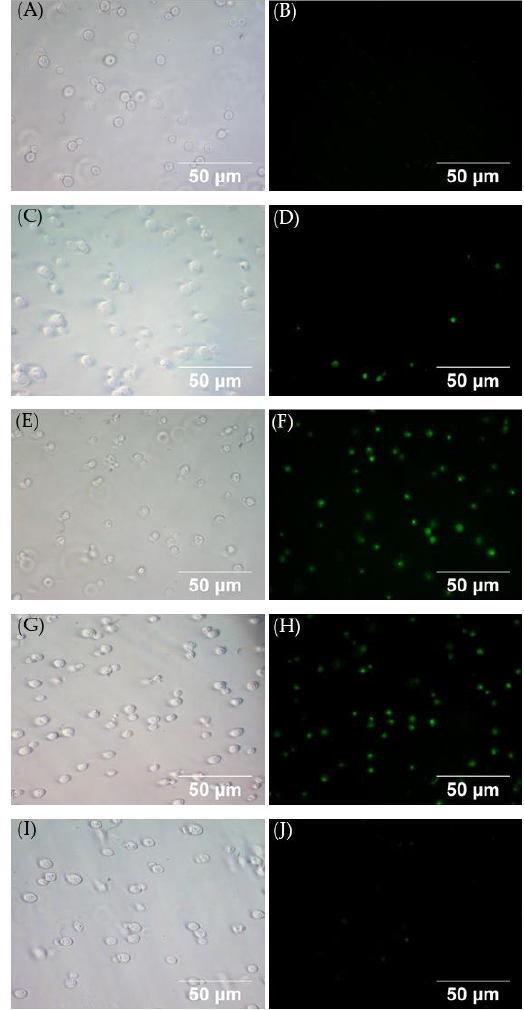
Figure 5. Phase contrast (left panels ) and fluorescent (right panels) images of C. neoformans H99. ( A ) and ( B ): Images of cells treated with SYTOX TM green alone; ( C ) and ( D ): Images of cells treated with SYTOX TM green and 1% Triton X-100; ( E ) and ( F ): Images of cells treated with SYTOX TM green and compound 7 (1×MIC); ( G ) and ( H ): Images of cells treated with SYTOX TM green and compound 11 (1xMIC); ( I ) and ( J ): Images of cells treated with SYTOX TM green and compound 13 (256 μg/mL).